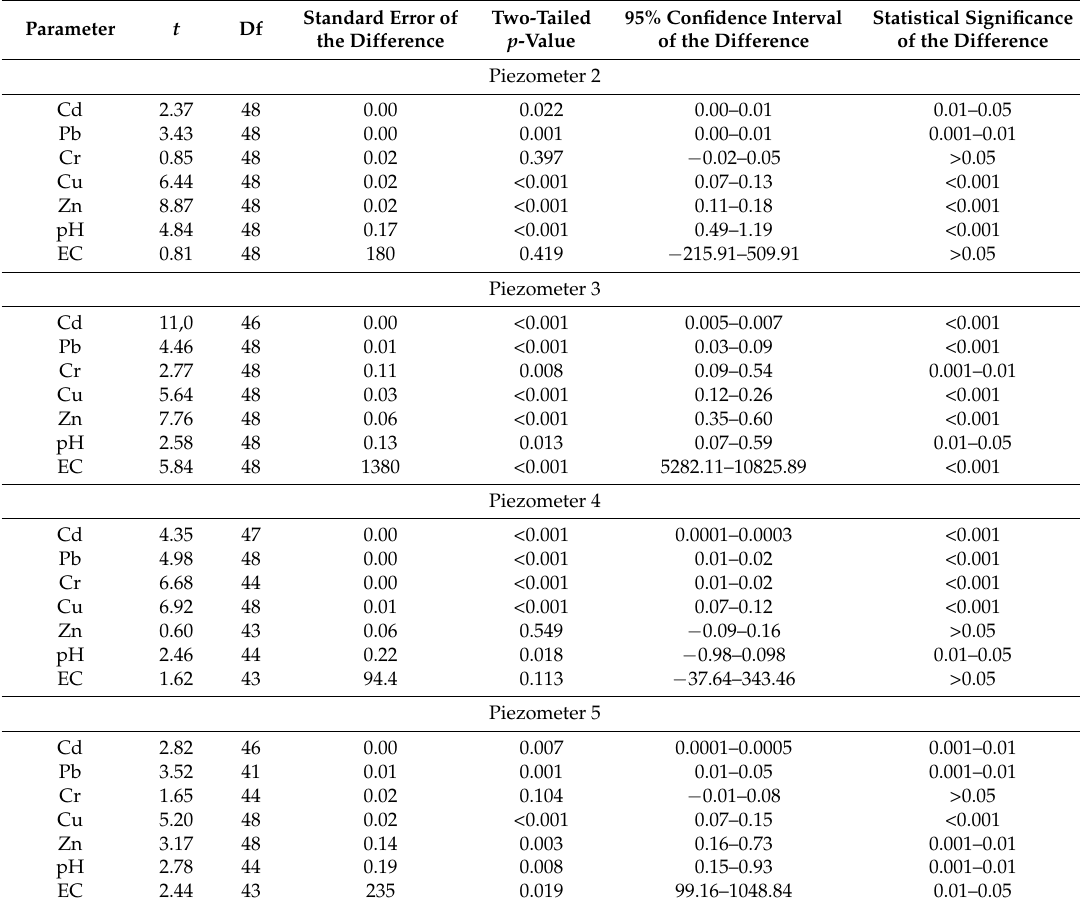
Table 2. t -test results for determination statistical significance of the difference between periods 1994–1998 and